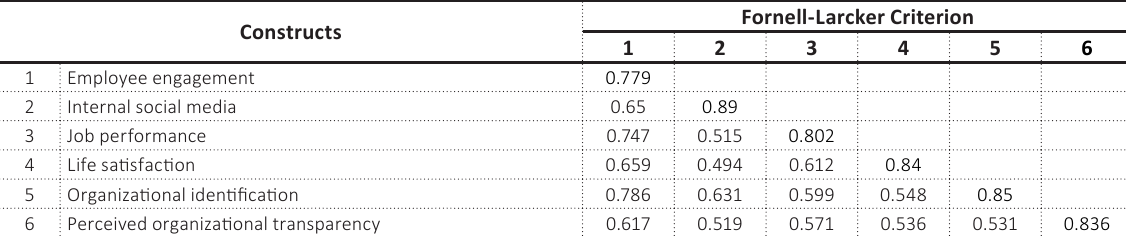
Table 3. Discriminant validity (Fornell-Larcker Criterion)